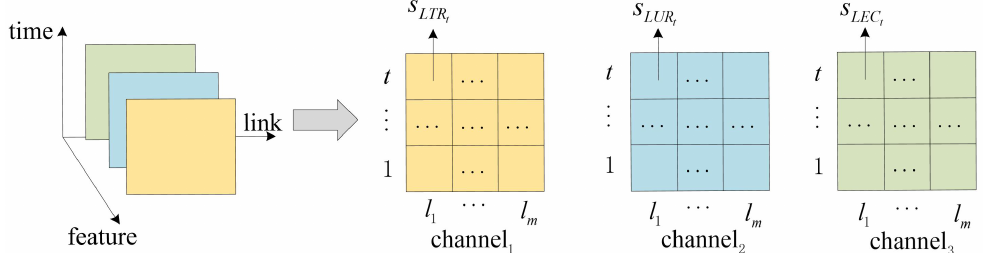
Figure 3. State feature